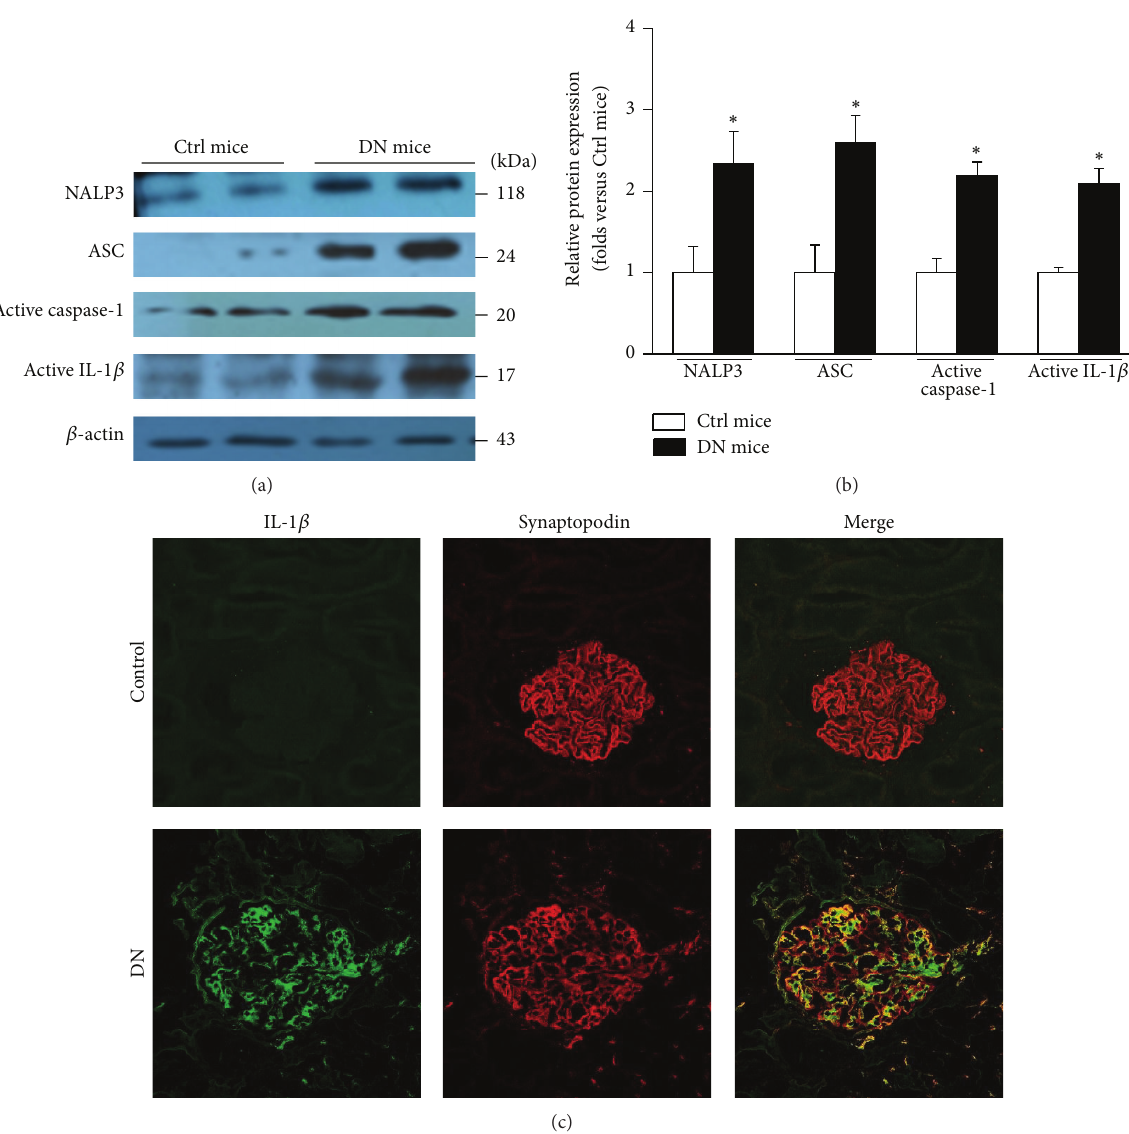
Figure 1: The NALP3 inflammasome is activated in the glomeruli of DN mice. (a) Western blotting gel document showing the expression of NALP3, ASC, active caspase-1, and active IL-1 𝛽 in the glomerular lysate of DN mice. (b) Summarized data presenting the protein expression of NALP3, ASC, active caspase-1, and active IL-1 𝛽 in the glomeruli of DN mice ( 𝑛 = 7 ). Ctrl mice: control mice; DN mice: diabetic nephropathy mice. ∗ 𝑃 < 0.05 compared with Ctrl mice. (c) Dual immunofluorescence staining of IL-1 𝛽 and synaptopodin in healthy control and DN patients. Original magnification: ×